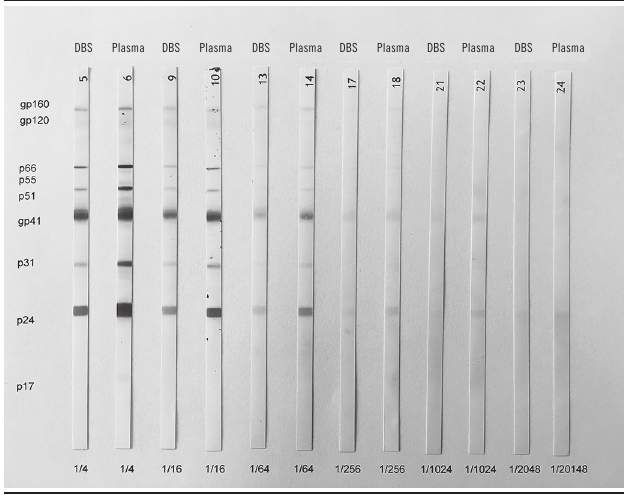
figurE 3 − Profile of bands detected in each dilution (ratio 2) of a DBS sample and corresponding plasma DBS: dried blood